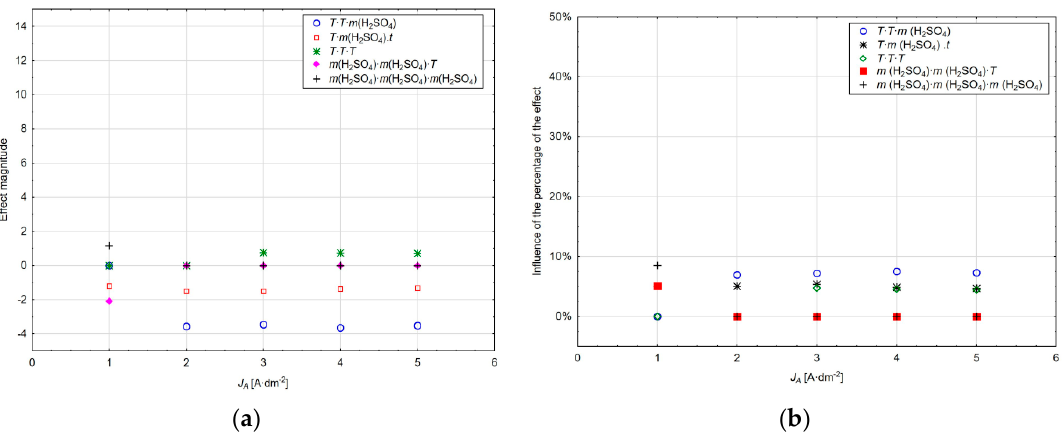
Figure 10. ( a ) The magnitude of the model three-level effects for J A = 1 to 5 A·dm − 2 ; ( b ) The influence of the percentage of the model three-level effects for J A = 1 to 5 A·dm − 2 .